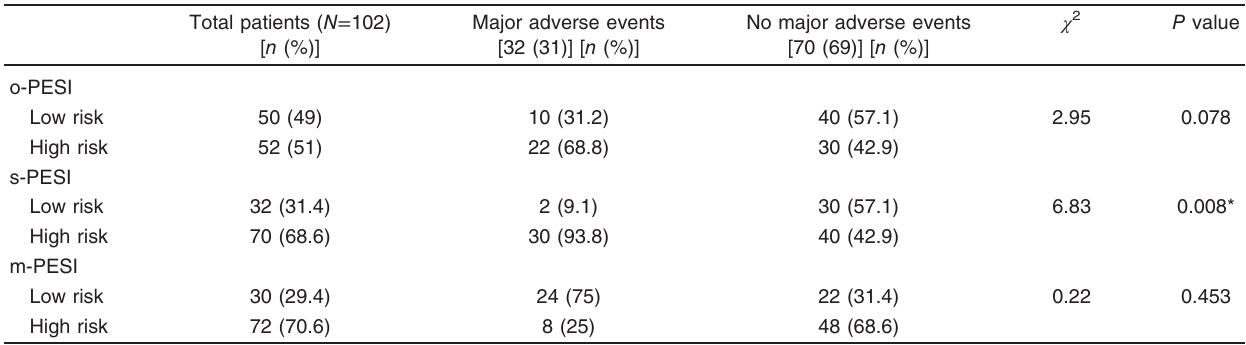
Table 5 Frequency of in-hospital major adverse events according to risk stratification of the studied scores Total patients ( N =